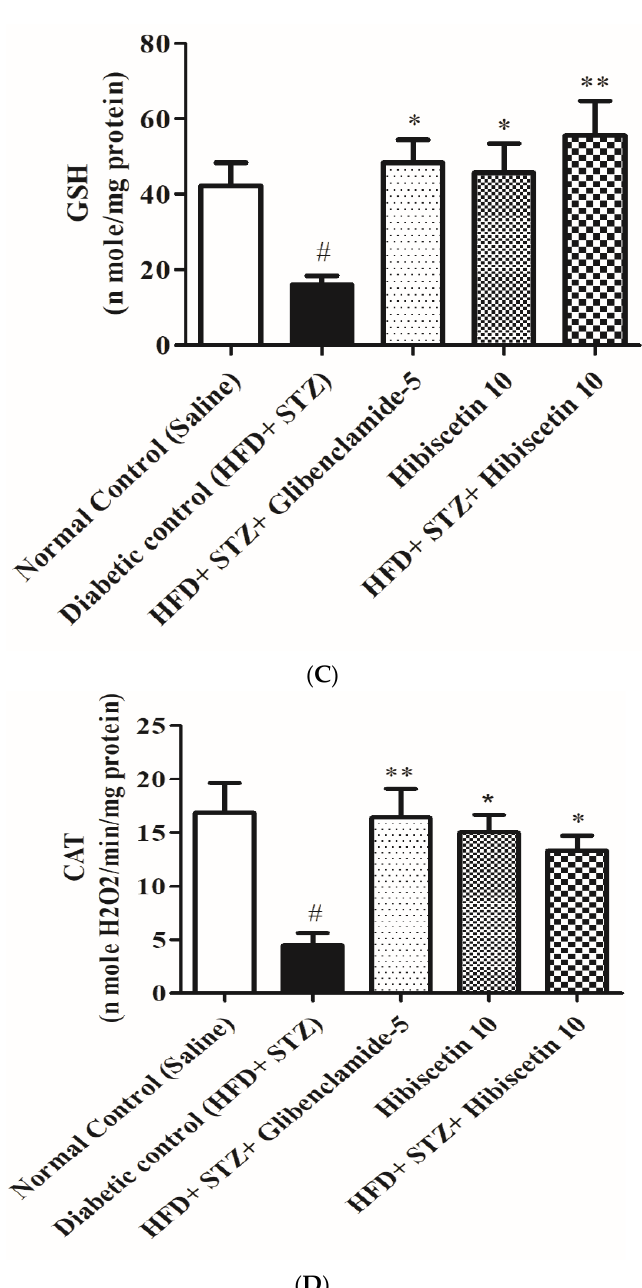
Figure 4. ( A – D ) Effect of hibiscetin on MDA, SOD, GSH, and CAT (n = 6). The mean SEM is used to express the data; ( # p < 0.05) saline vs. HFD+STZ; (*** p < 0.001, ** p < 0.01, and * p < 0.05) HFD+STZ vs. treatment group.